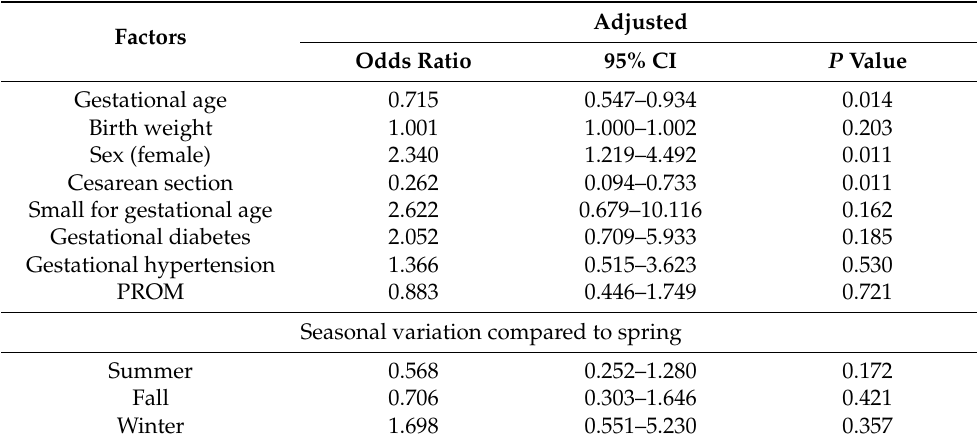
Table 3. Risk factors for vitamin D deficiency at birth in preterm